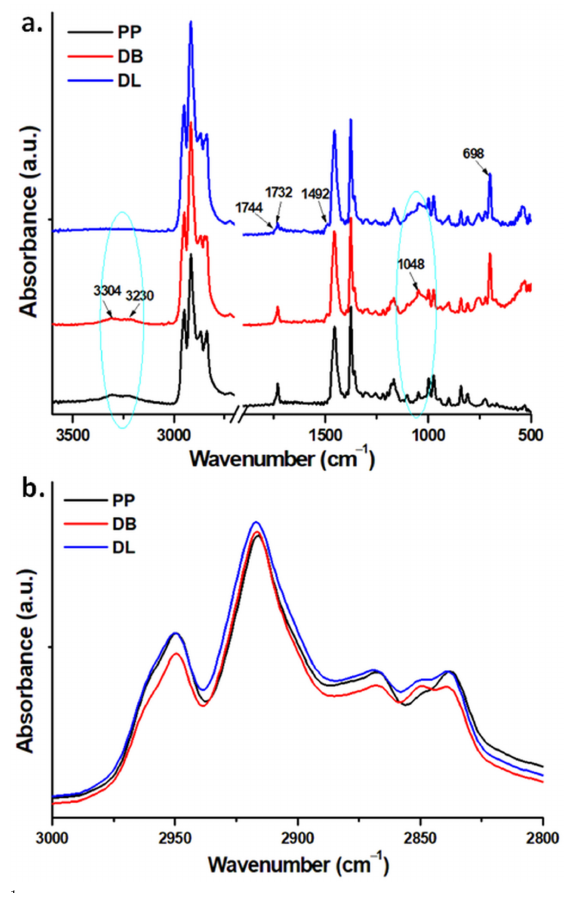
Figure 11. FTIR spectra of PP and hybrid composites DB and DL ( a ); normalized spectra of PP, DB and DL between 3000 and 2800 cm − 1 ( b